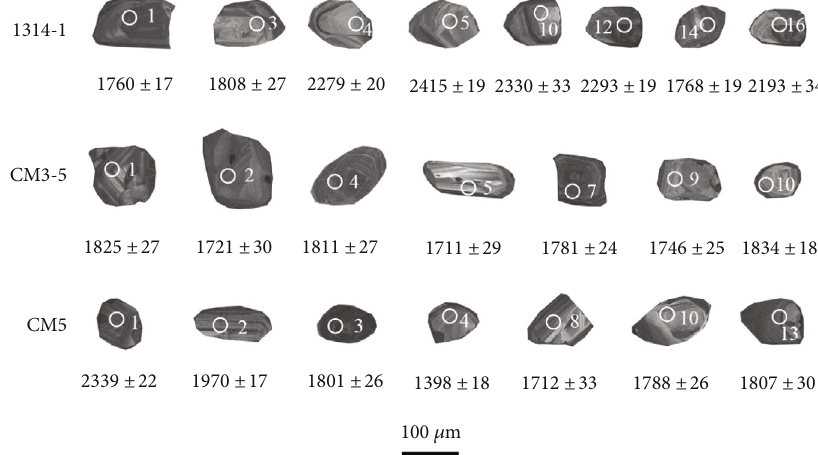
Figure 4: Cathodoluminescence (CL) images of selected zircon grains from the studied sample.